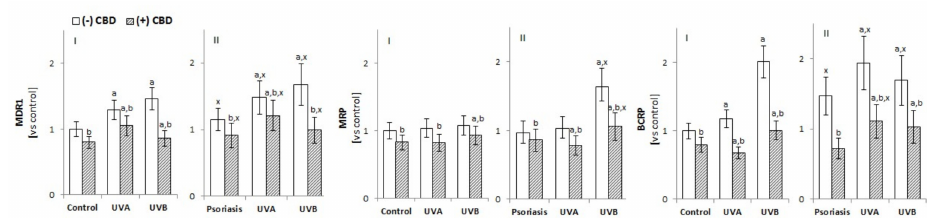
Figure 6. E ff ect of CBD (4 µ M) on the multidrug resistance protein 1 (MDR1), multidrug resistance protein (MRP), and breast cancer resistance protein (BCRP) transporters in keratinocytes exposed to UVA (30 J / cm 2 ) and UVB (60 mJ / cm 2 ) radiation. The keratinocytes were obtained from healthy subject (n = 15) ( I ) and patients with psoriasis vulgaris (n = 30) ( II ) The mean values ± SD are presented with statistically significant di ff erences: a -vs. control / psoriasis group; b -vs. group without CBD; x -psoriasis vs. control group; p <